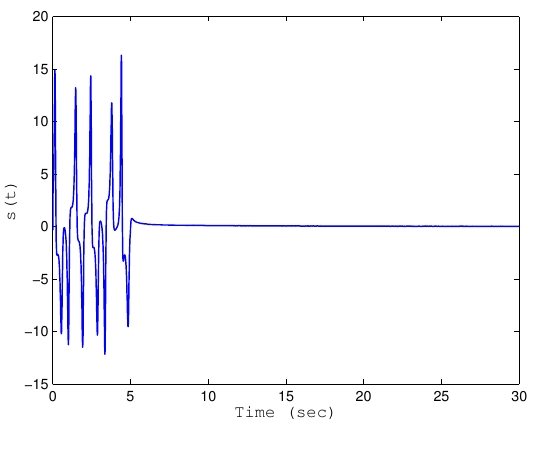
Figure 10. The sliding